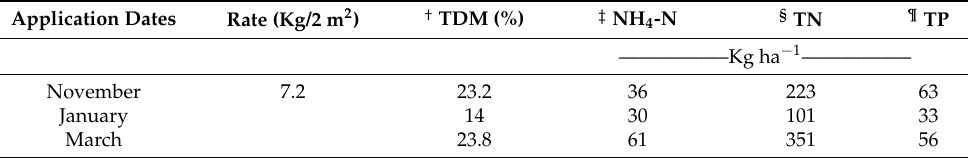
Table 2. Manure characteristics used for the snowmelt runoff study; Brookings, SD.